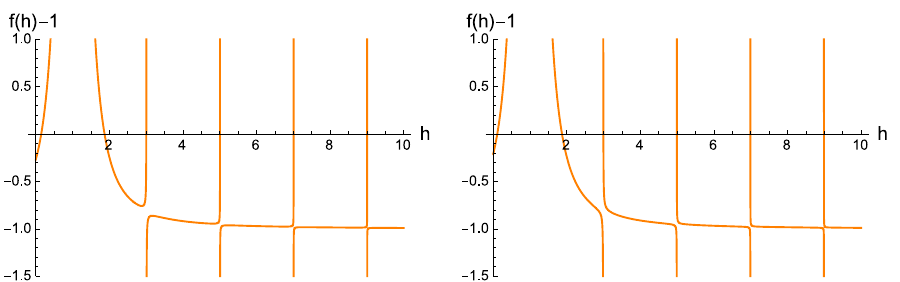
Figure 14 . Plots of f ( h ) (cid:0) 1 at g = 0 : 08, for d = 2 : 02 (left), and d = 1 : 98